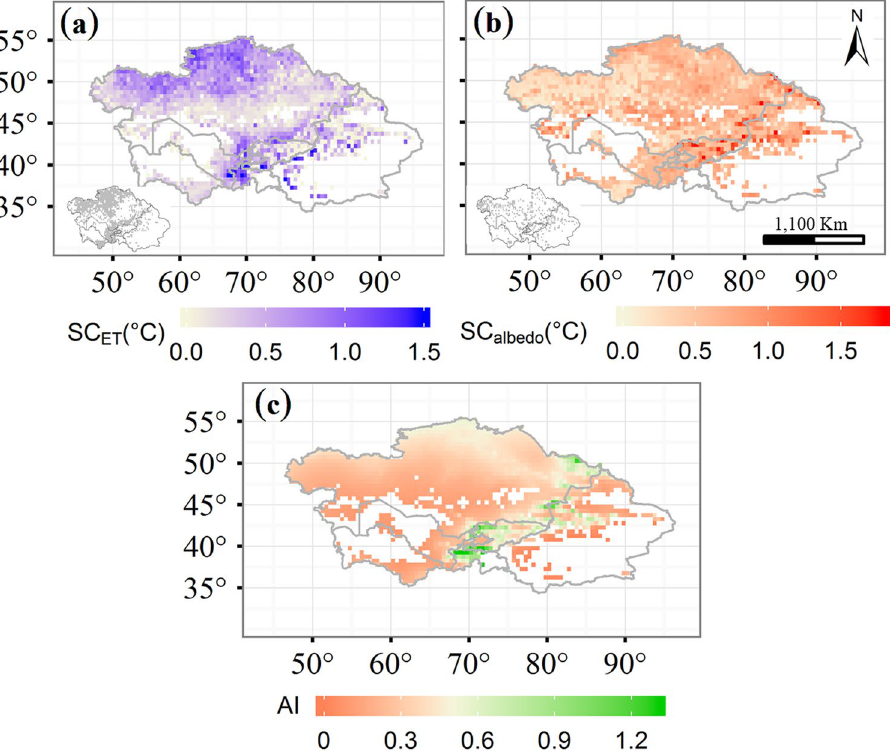
Figure 4. The spatial distribution of the s ensitivity of evapotranspiration (ET) ( a ), albedo ( b ) to the NDVI changes (every 0.1 increment), and the spatial distribution of the aridity index ( c ). The map was generated by using free software R (R Core Team (2015). R: A language and environment for statistical computing. R Foundation for Statistical Computing, Vienna, Austria. URL: https://www.R-project.org/).